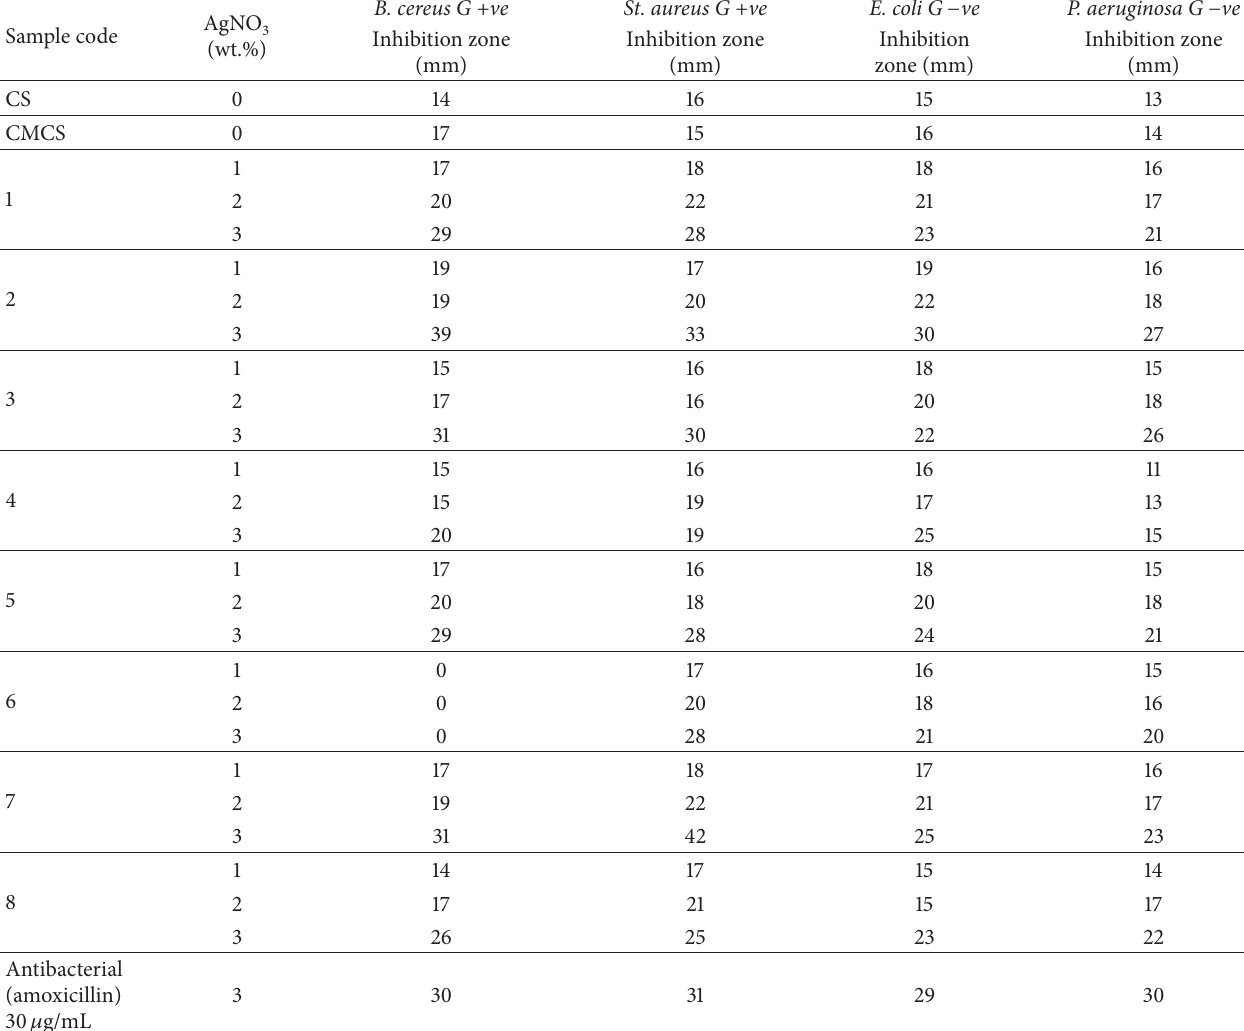
Table 3: Antibacterial activities of CS or CMCS/Schiff-base/AgNPs. Sample